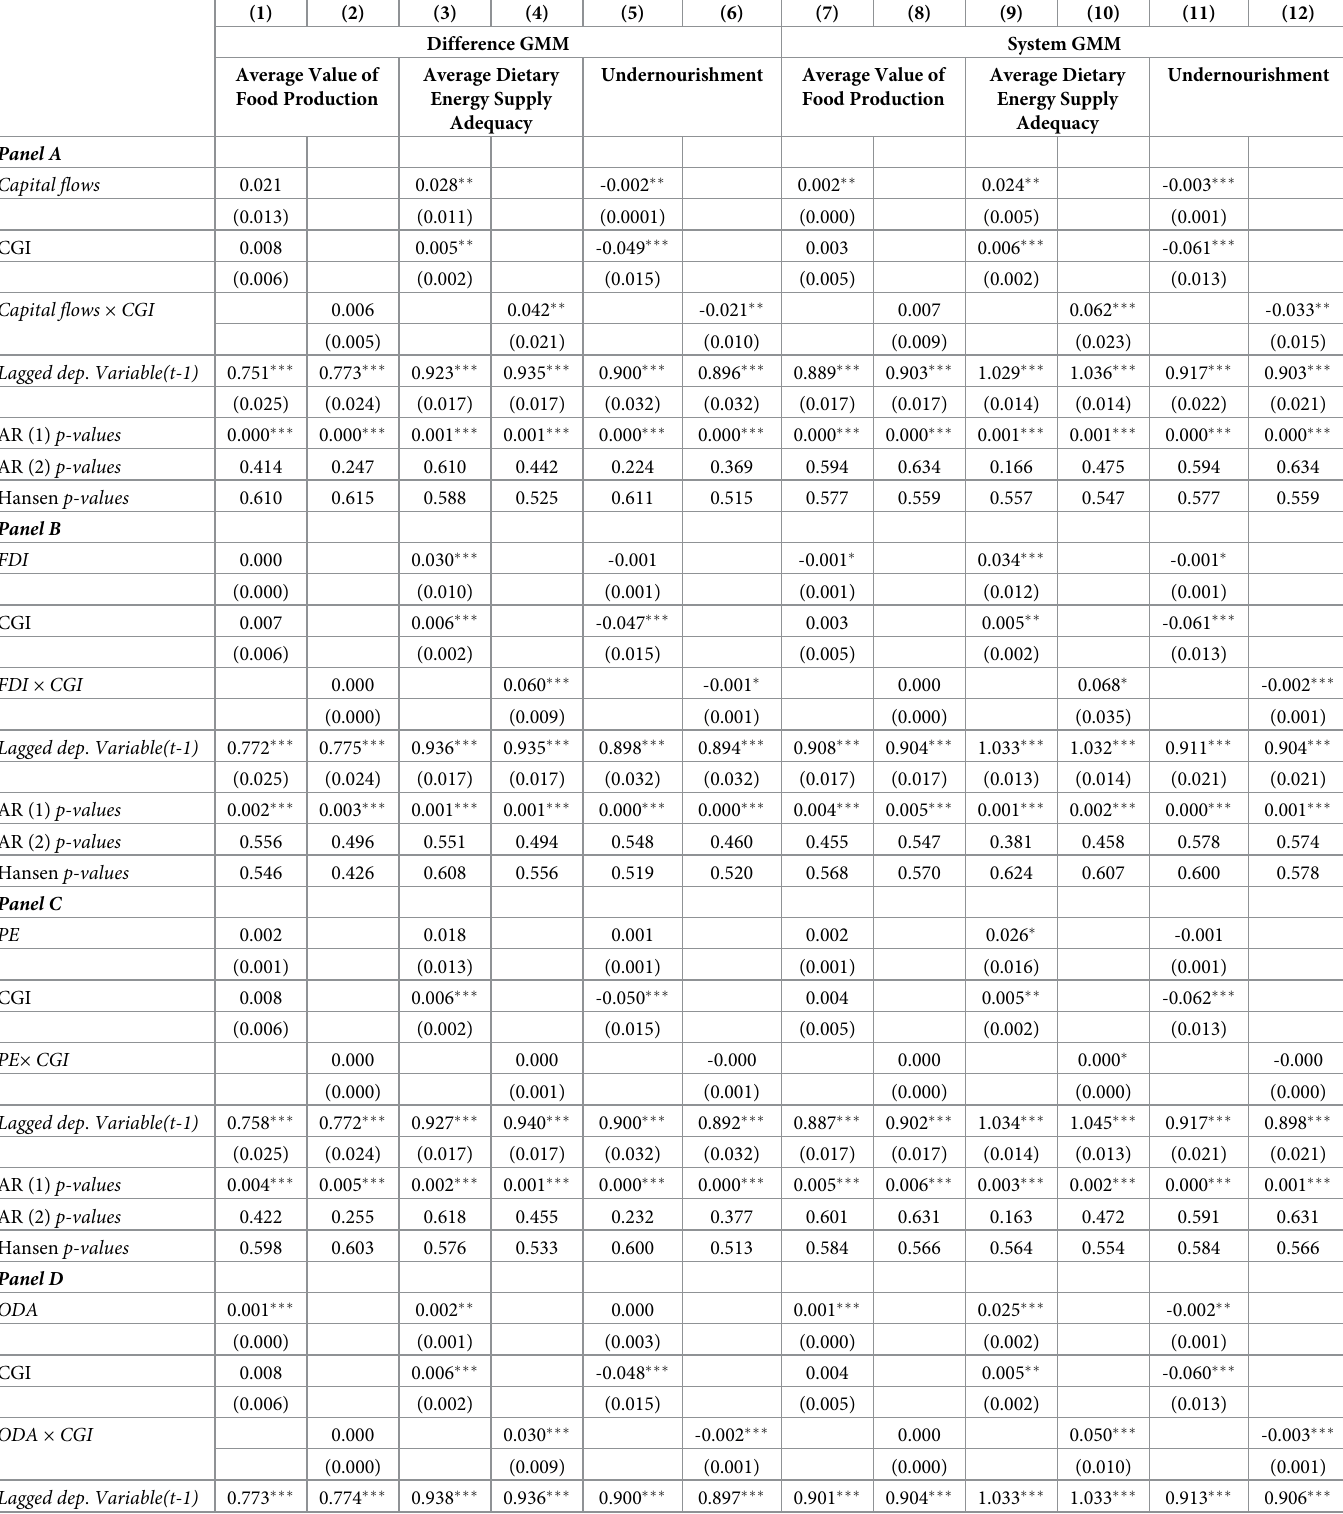
Table 2. The impact of governance and capital flows on food and nutrition security and